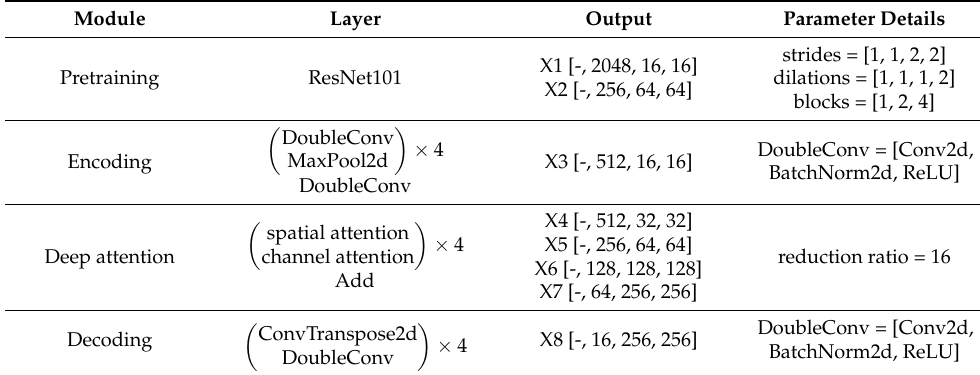
Table 1. Configuration details of